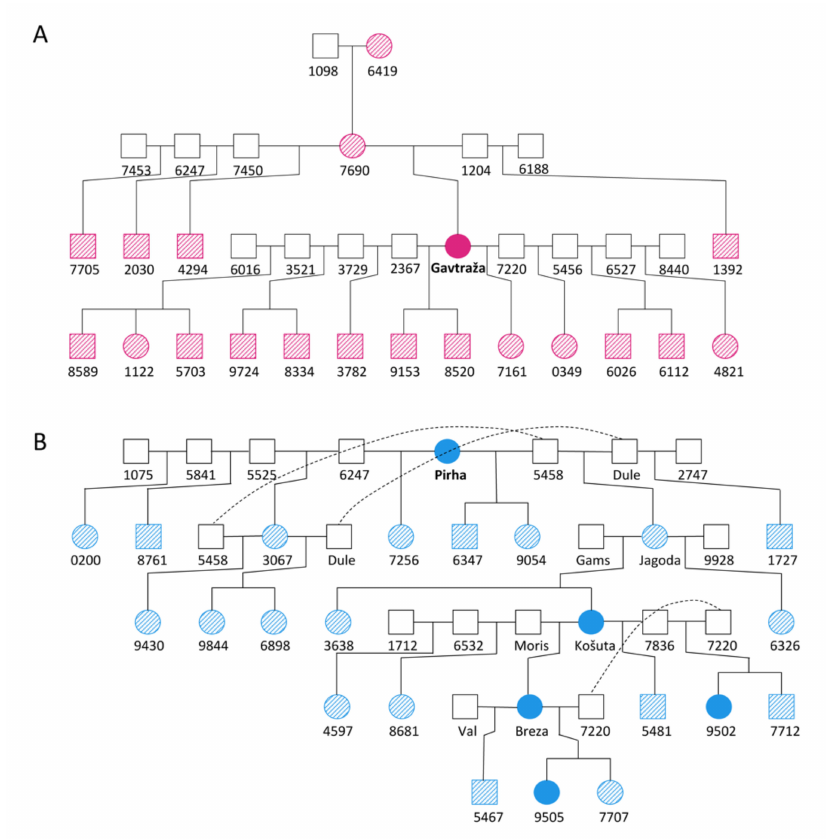
Figure 3. Reduced pedigrees of two Cika cows with identified T10432C mtDNA mutation. ( A ) Pedigree of cow Gavtraža and ( B ) pedigree of cow Pirha. Solid colour represents individu- als with a genotyped mutation. Individuals carrying the mutation (based on pedigree data) are shown with diagonal